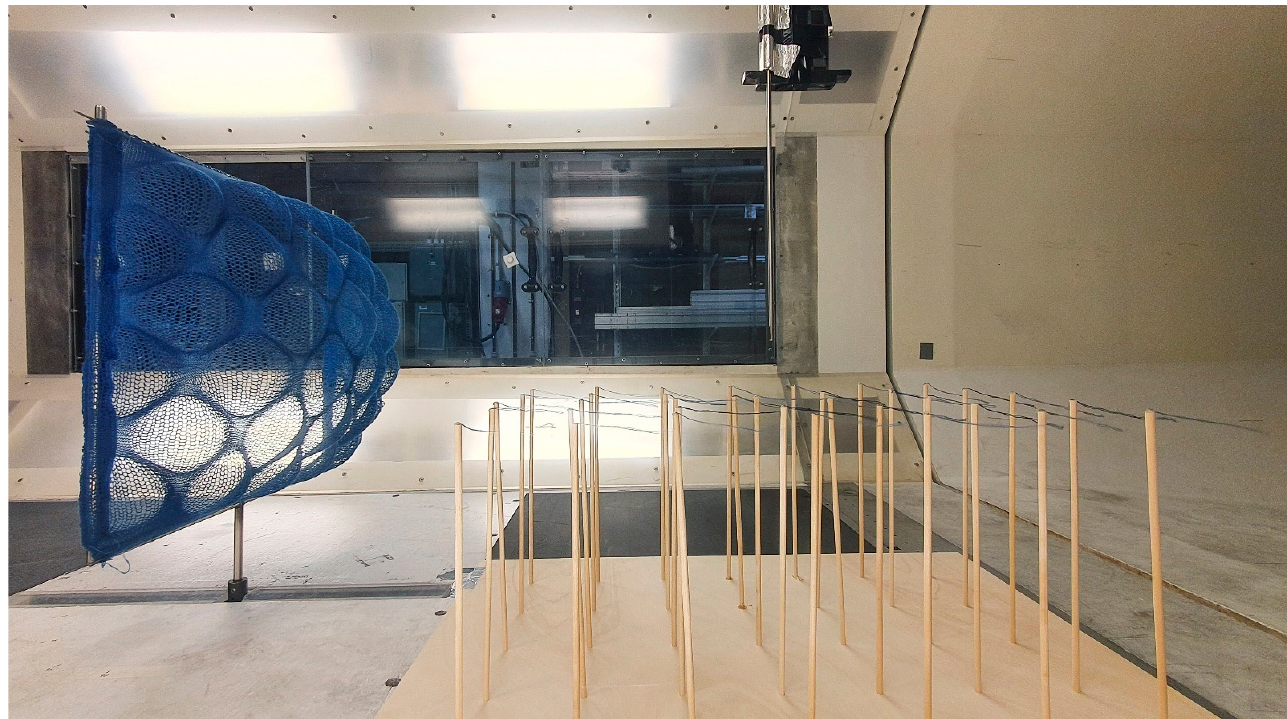
Figure 8. The wind tunnel setup for the experiments. Top left, side elevation view; top right, front elevation view; and bottom left, top plan view. Compare with photo in Figure 9. * width of steel frame, center to center of the steel rods.